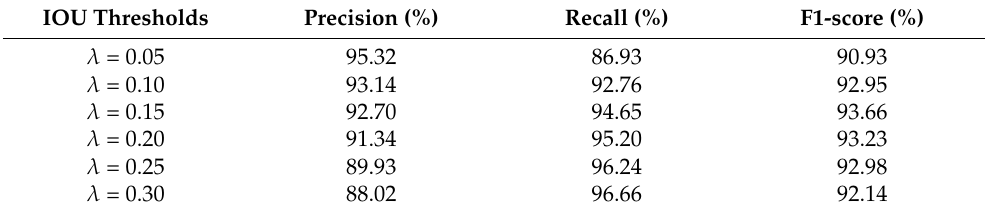
Table 4. Performance of field sugarcane seedling population counting method using different IOU